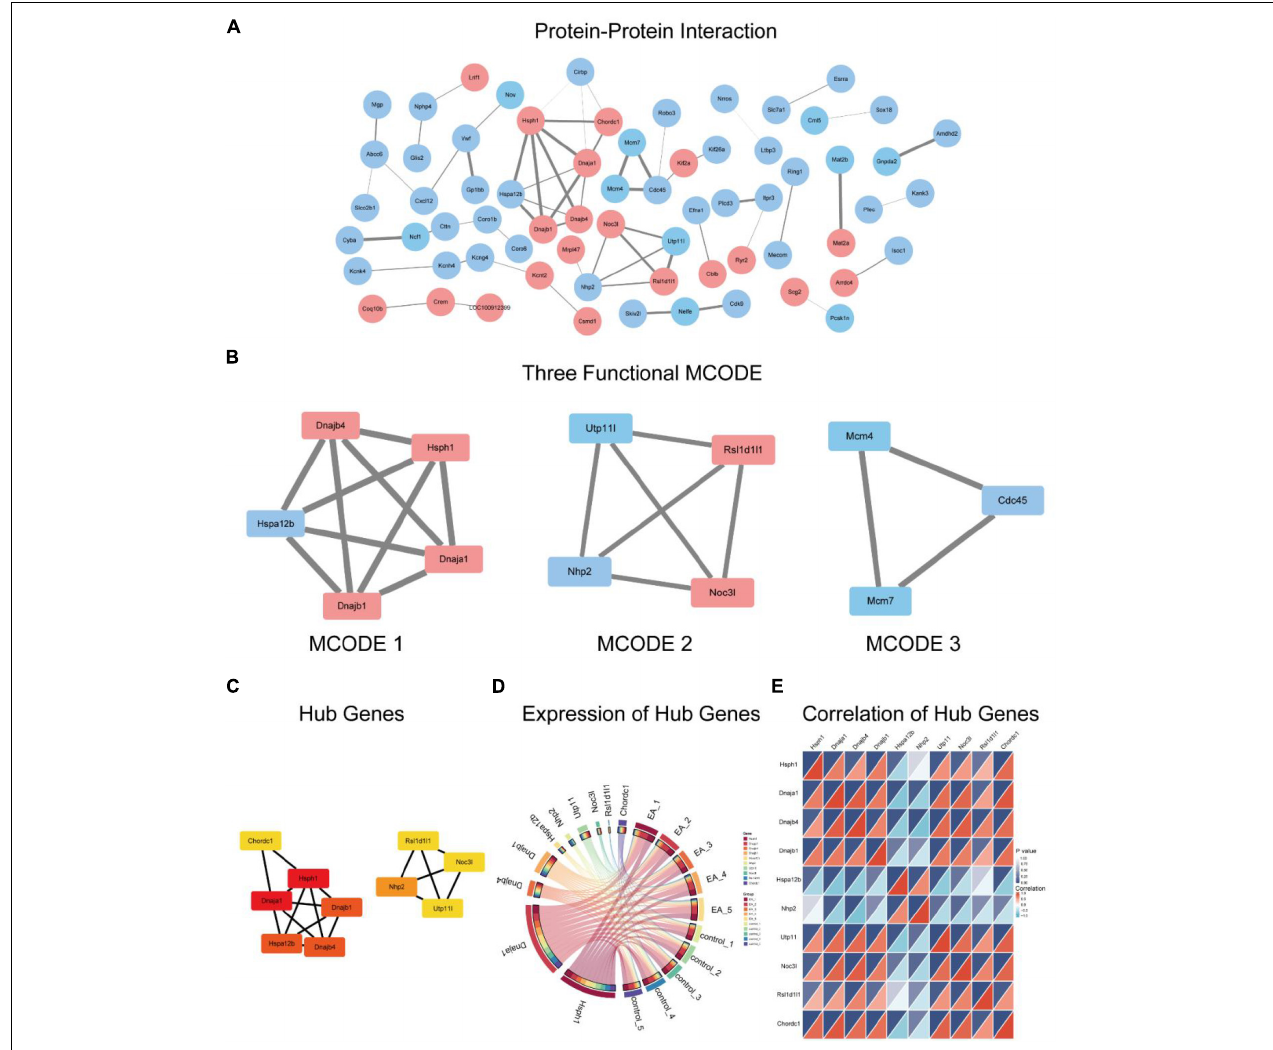
FIGURE 6 | Protein-protein interaction of the DEGs (A) , red represents up-regulation genes, blue represents down-regulation genes, and the thicker the line, the higher the connection score. Three functional modules within the PPI (B) . 10 hub genes (C) and their expression among samples (D) , correlation between 10 hub genes (E)